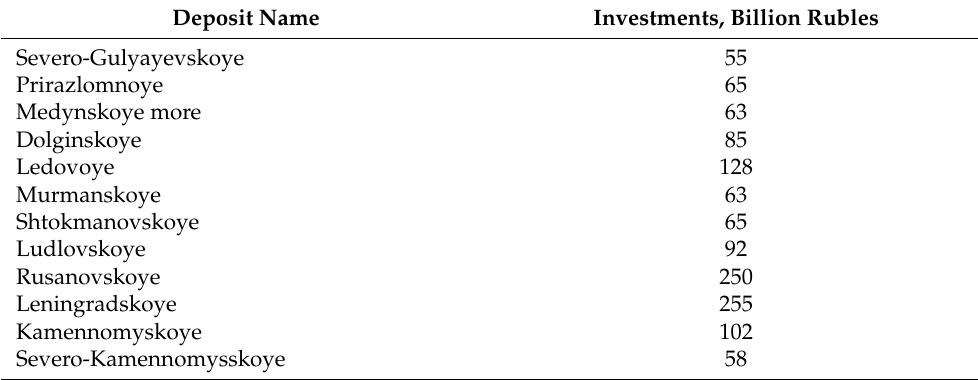
Table 2. Required investments for the perspective offshore field development